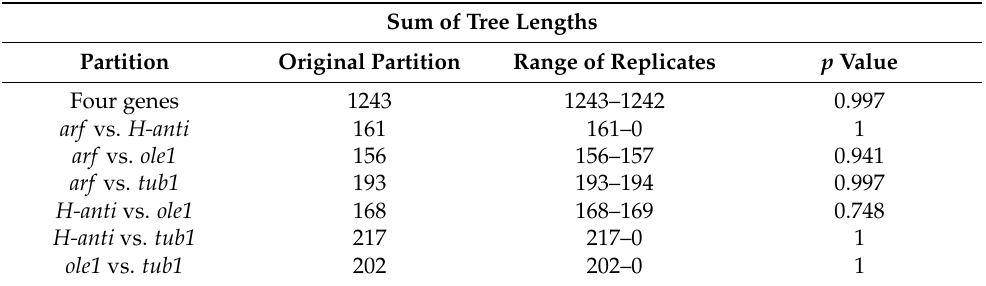
Table 3. Data for the incongruence length difference test using the sequences of the four genes studied. Sum of Tree